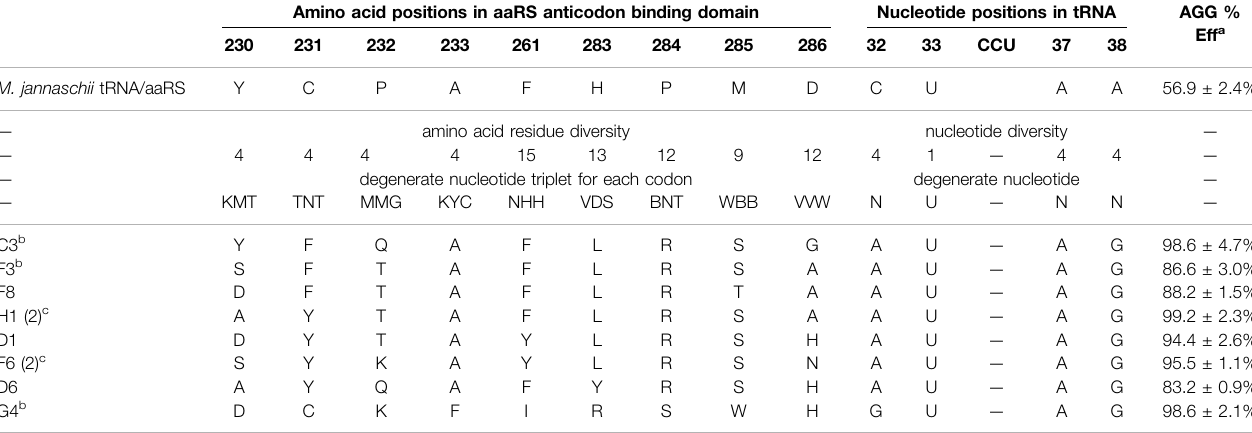
TABLE 1 | Sequences and AGG reassignment ef fi ciencies for M. jannaschii tyrosyl tRNA/aaRS variants selected from the library. Amino acid positions in aaRS anticodon binding